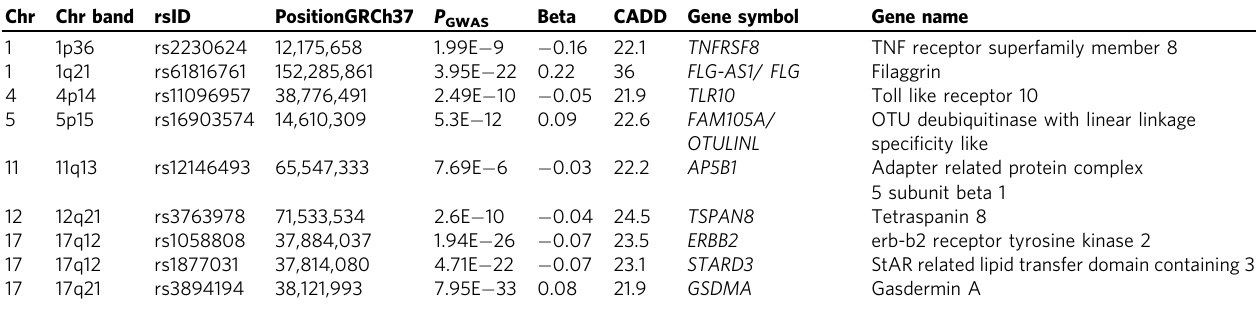
Table 2 Deleterious coding SNPs associated with asthma or in LD with asthma-associated SNPs outside of the MHC locus. Chr Chr band rsID